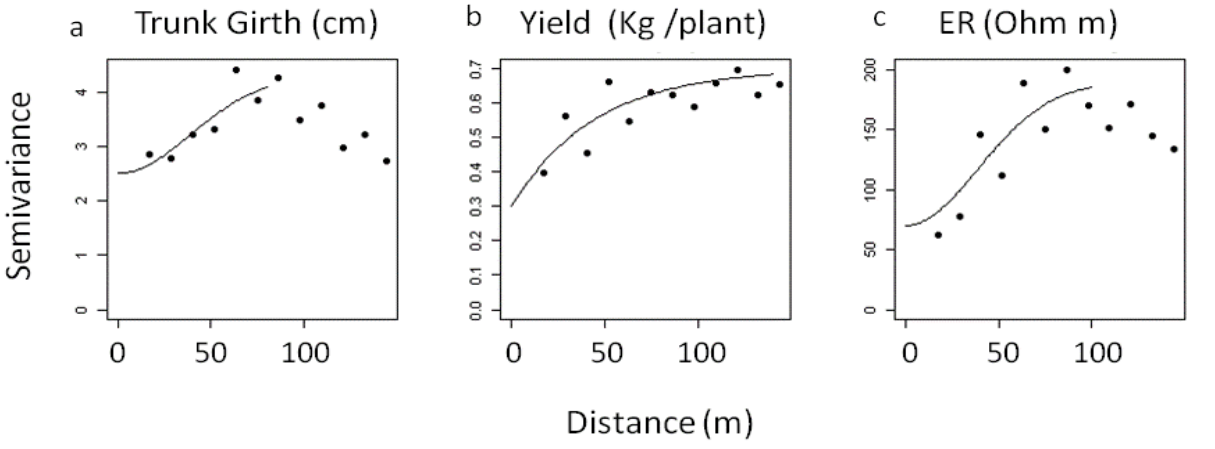
Figure 5. Empirical variograms of ( a ) trunk girth, ( b ) yield and ( c ) soil electrical resistivity (ER) overlaid by theoretical variogram models.